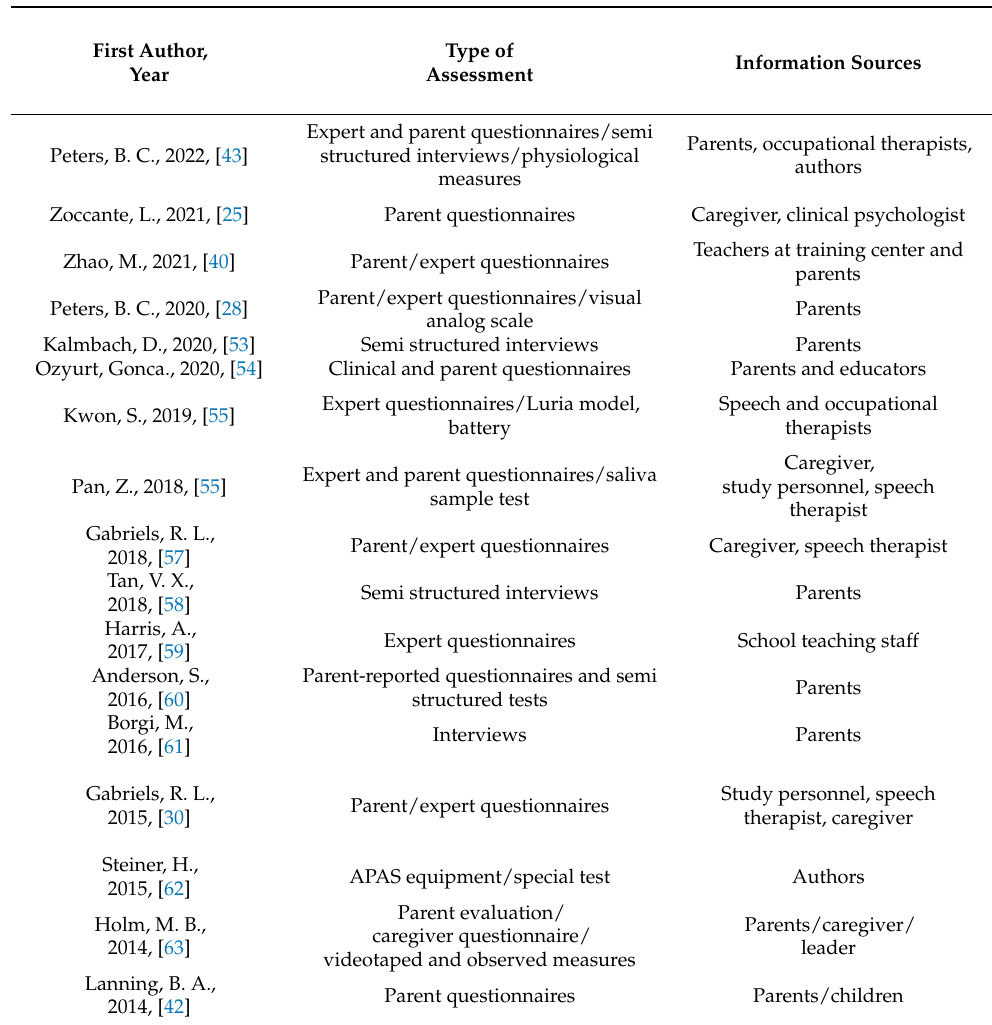
Table 7. Assessor